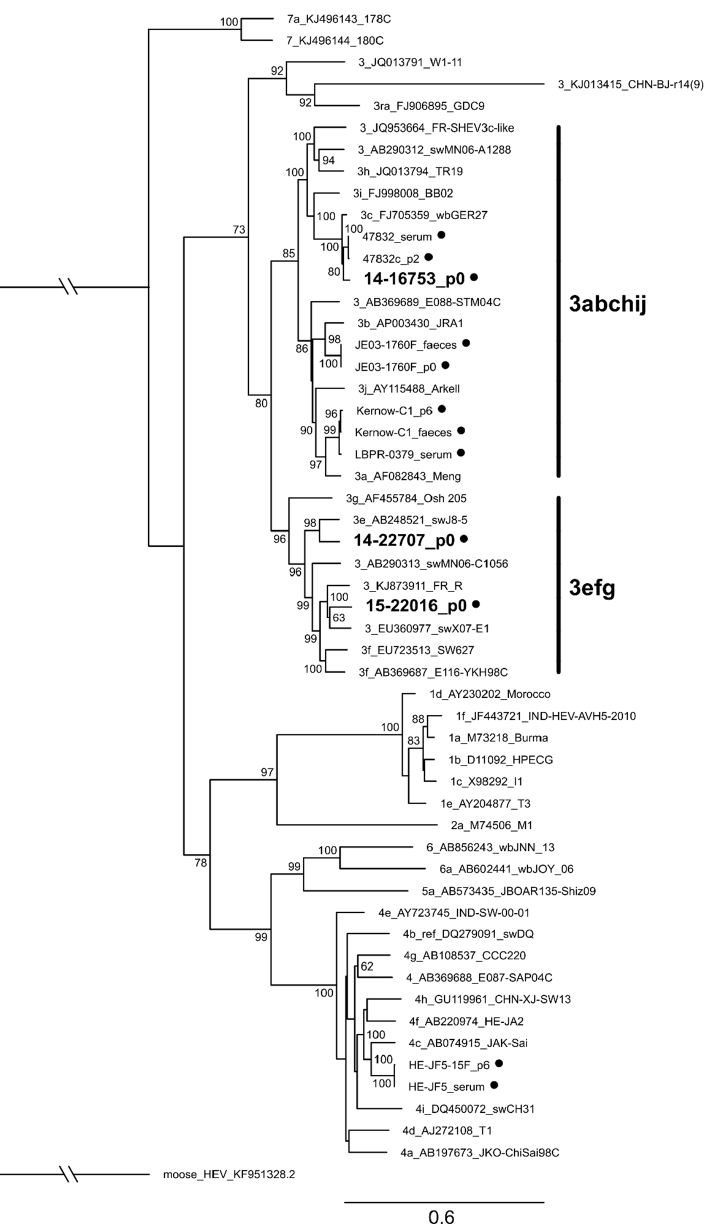
Figure 7. Phylogenetic relationship of HEV strains isolated in cell culture together with reference strains. The tree is based on complete genome sequences and was rooted by using moose HEV as an outgroup. Sequences of the HEV genotype reference strains as proposed by Smith et al. [3] were aligned together with the new isolates as well as with all HEV strains isolated in cell culture with available whole genome sequences as of April 2019. Branches with a bootstrap value of >60% were labelled. Reference sequences are denoted by subtype, GenBank accession number and strain name. Strains isolated in cell culture are marked with black circles and denoted with strain name and source material or number of passages (p). Novel isolates are shown in bold. Bold vertical lines denote subclades 3abchij and 3efg of genotype 3.